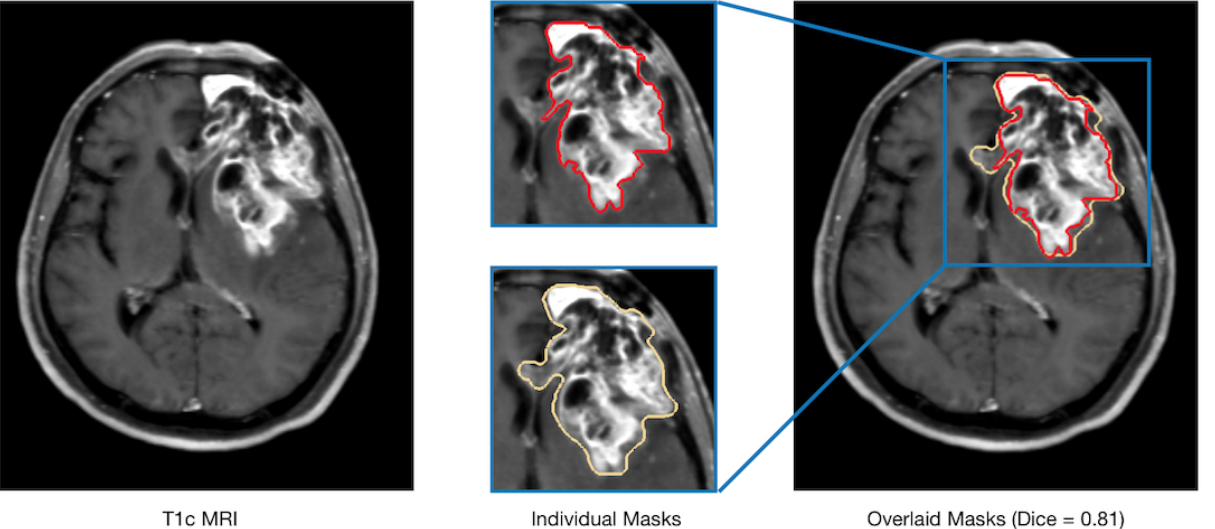
Figure 5. A T1c tumor image and its corresponding tumor masks created by two neuroradiologists independently, which shows the disagreement between annotators. MRI: magnetic resonance imaging; T1c: gadolinium-contrast-enhanced T1-weighted